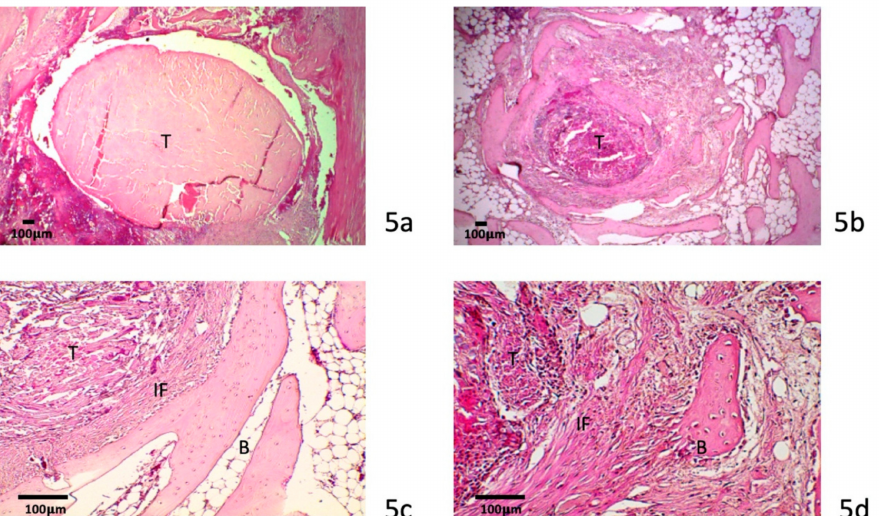
Figure 5. Four-week specimens histology. Histology of a tendon (T)-to-bone (B) interface (IF) in a 4-week specimen in the control group ( a ) and the study group ( b ). A wider interface with dense fibrovascular tissue formation in the study group was found. Sharpey fiber-like tissue was more observed 4 weeks after collagenase treatment ( c , d ) (scale bar: 100 µ